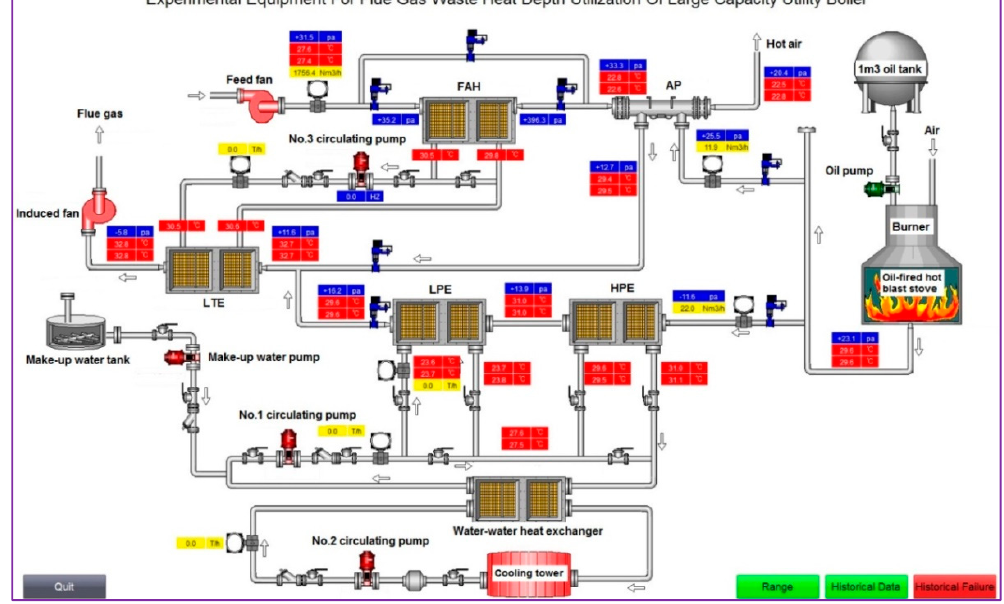
Figure 7. Data acquisition interface. AP: Air Preheater; FAH: Front located Air Heater; LTE: Low Temperature Economizer; LPE: Low Pressure Economizer; HPE: High Pressure Economizer.